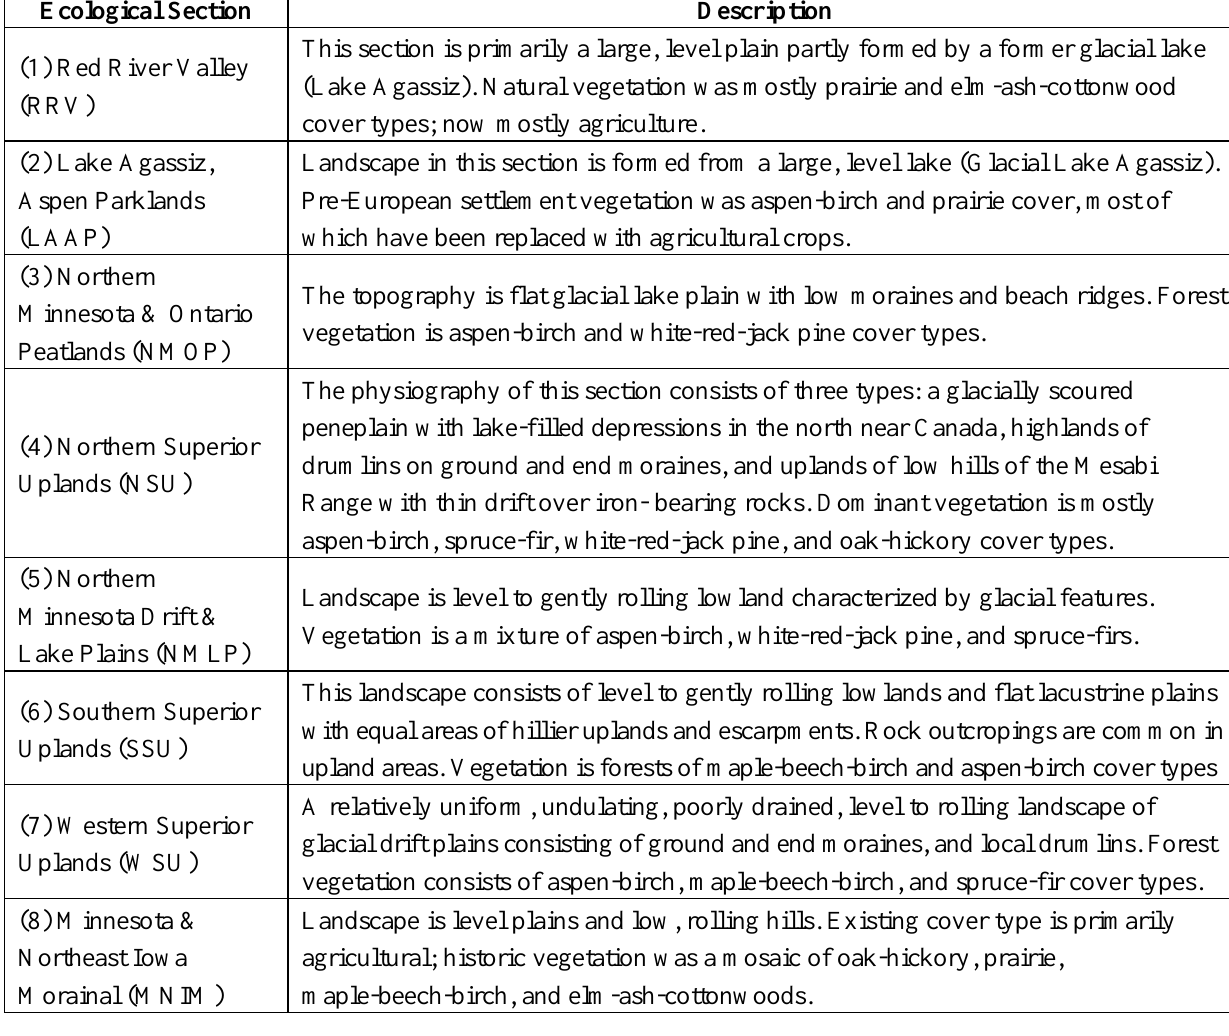
Table 2. Description of Minnesota’s ecological sections (Adapted from [36]). Ecological Section